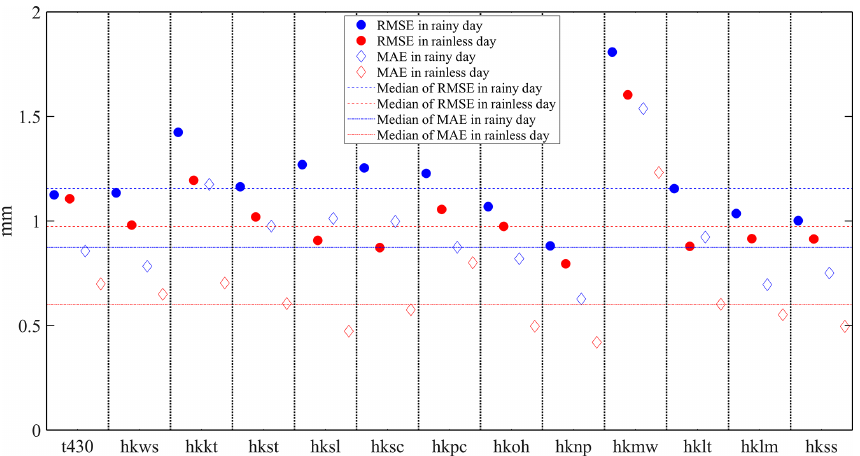
Figure 5. Comparison of SWV residuals in zenith direction: circles for RMSE and diamonds for MAE; blue for rainy days and red for rainless days.